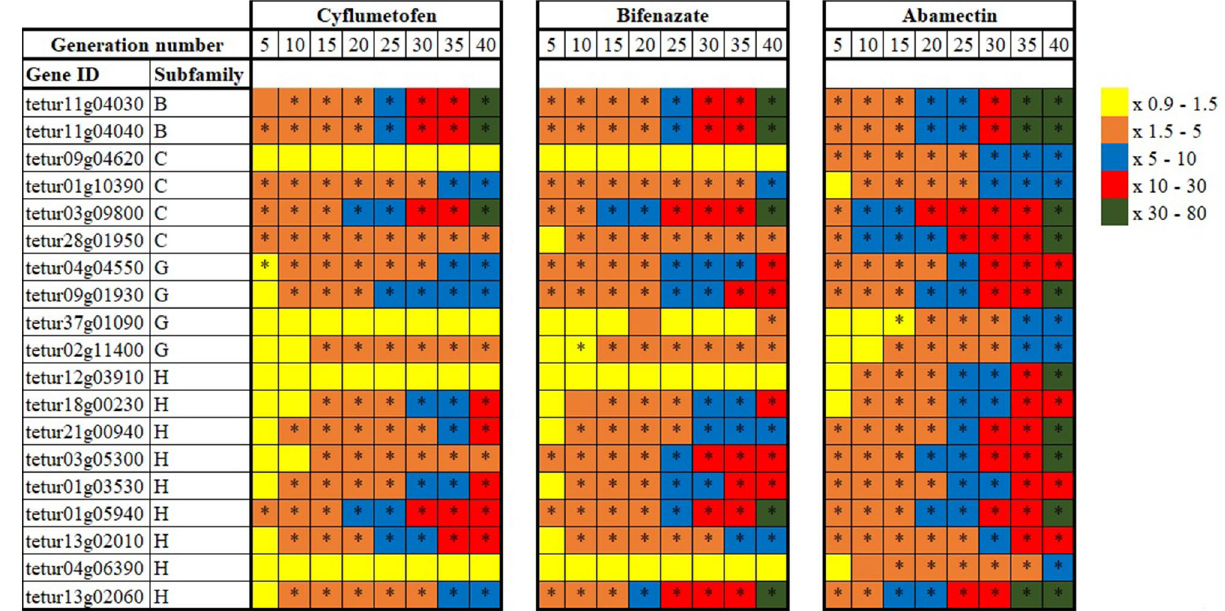
Figure 2. Transcription profiles of 19 ABC transporter genes from the ABCB, ABCC, ABCG, and ABCH subfamilies after the selection for resistance to cyflymetofen, bifenazatem and abamectin. Transcription levels are shown as mean-fold transcription of T. urticae resistant strains relative to the laboratory susceptible strain. Asterisks indicate significant differences (one-way ANOVA model, P ≤